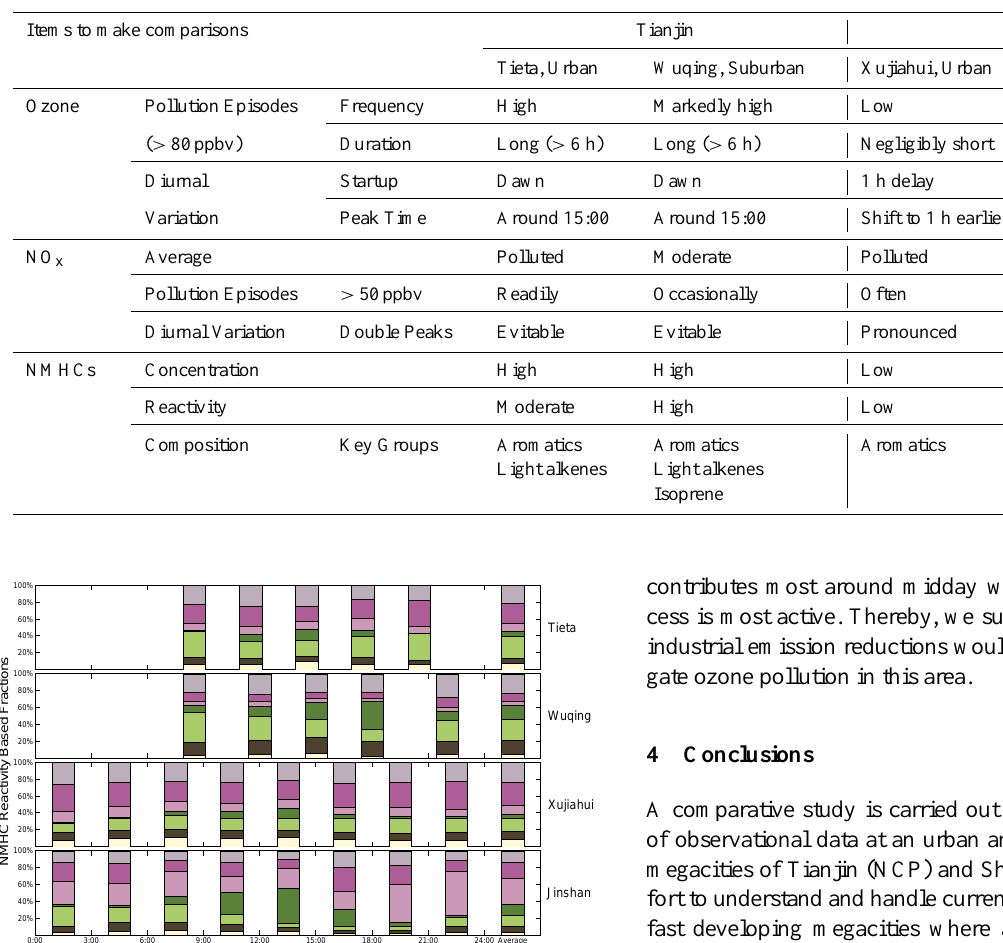
Fig. 6. Average diurnal fractions of different NMHC groups at each